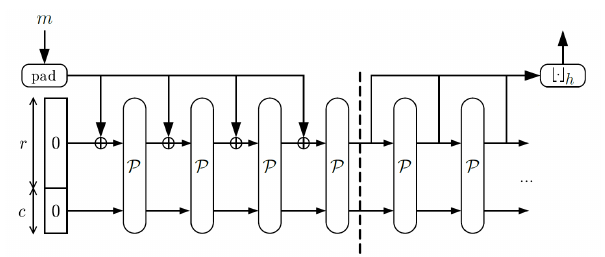
Figure 1: A sponge hash function instantiated with a permutation P